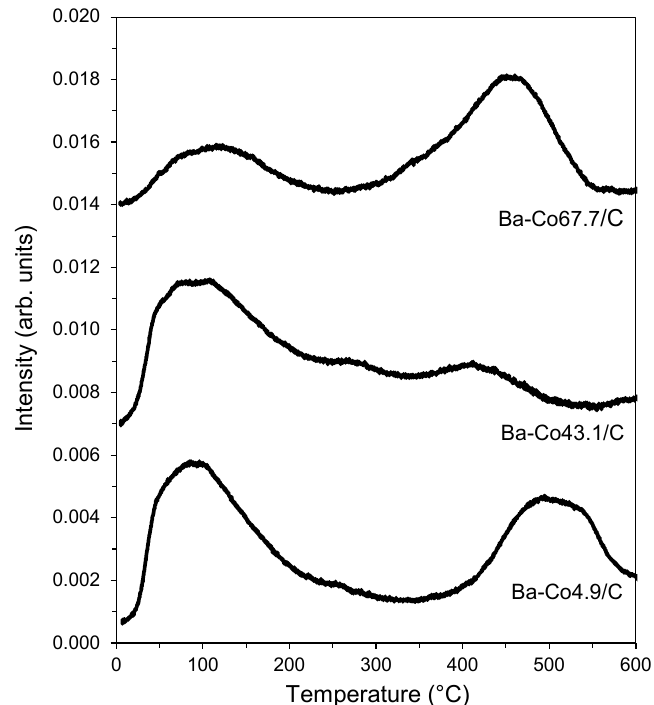
Figure 5. H 2 -TPD profiles of the selected catalysts of low (Ba-Co4.9/C), medium (Ba-Co43.1/C), and high (Ba-Co67.7/C) cobalt content. Table 2. Chemisorptive characteristics of the Ba-Co/C catalysts.